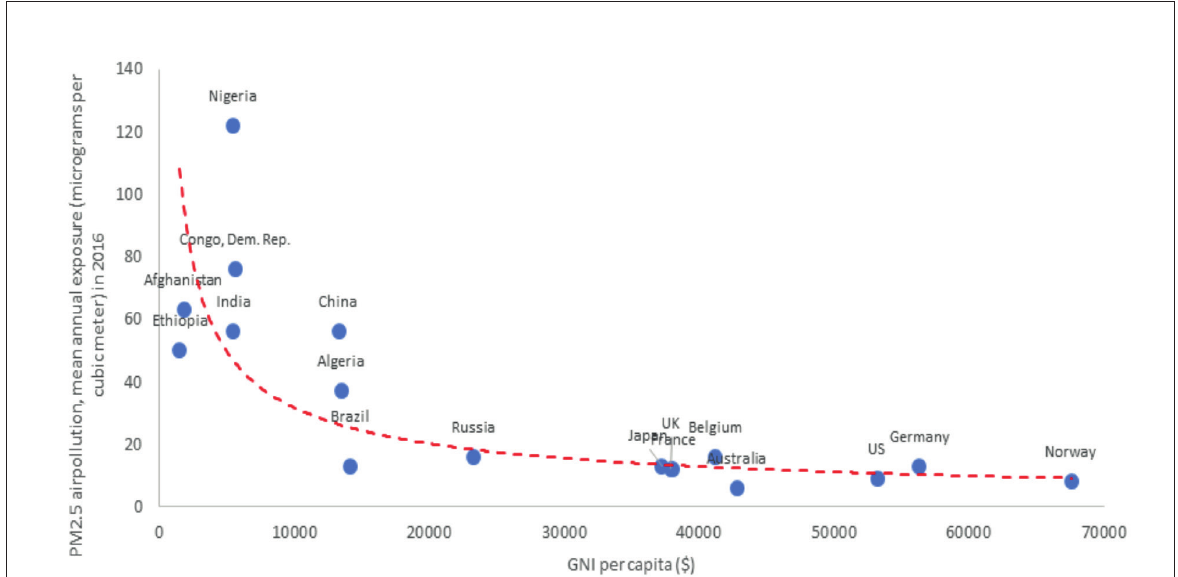
Figure 7. Mean annual PM exposure vs GNI per capita for both HCI’s and OECD countries with strong econo- 2.5 mies.